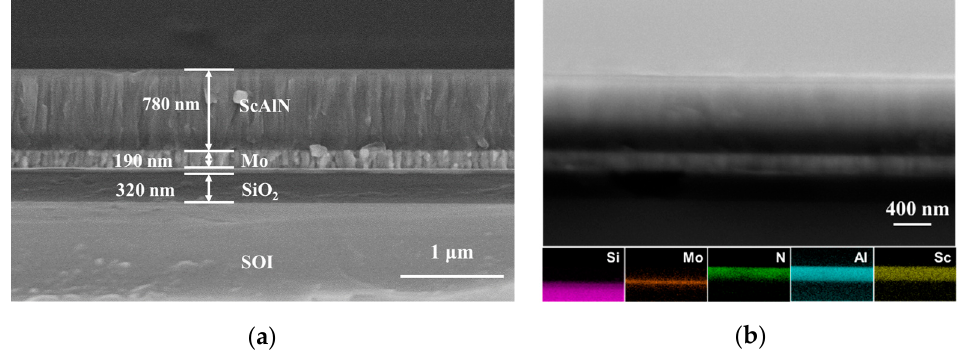
Figure 1. SEM micrographs and analysis of ScAlN thin film deposited on Mo/SiO 2 /AlN/SOI: ( a ) SEM micrographs; ( b ) EDS mapping .